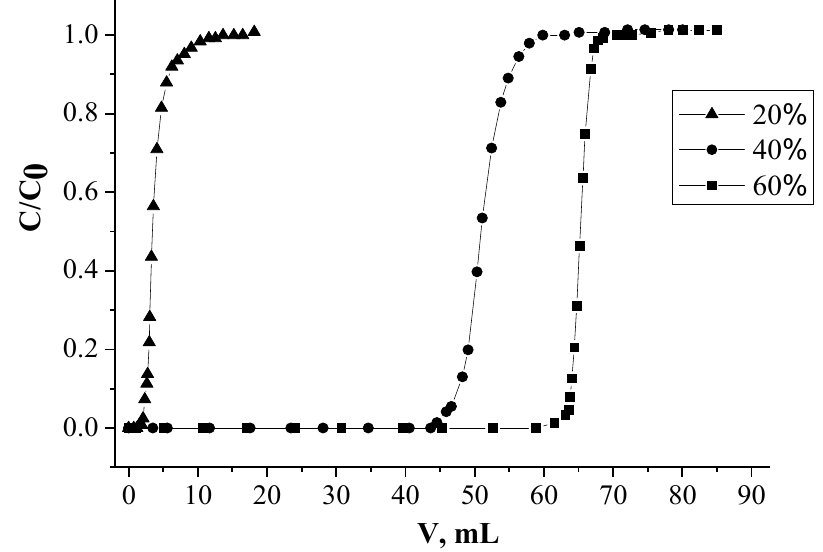
Figure 3. Influence of the extractant percentage in SIRs on recovery of Nd(III).